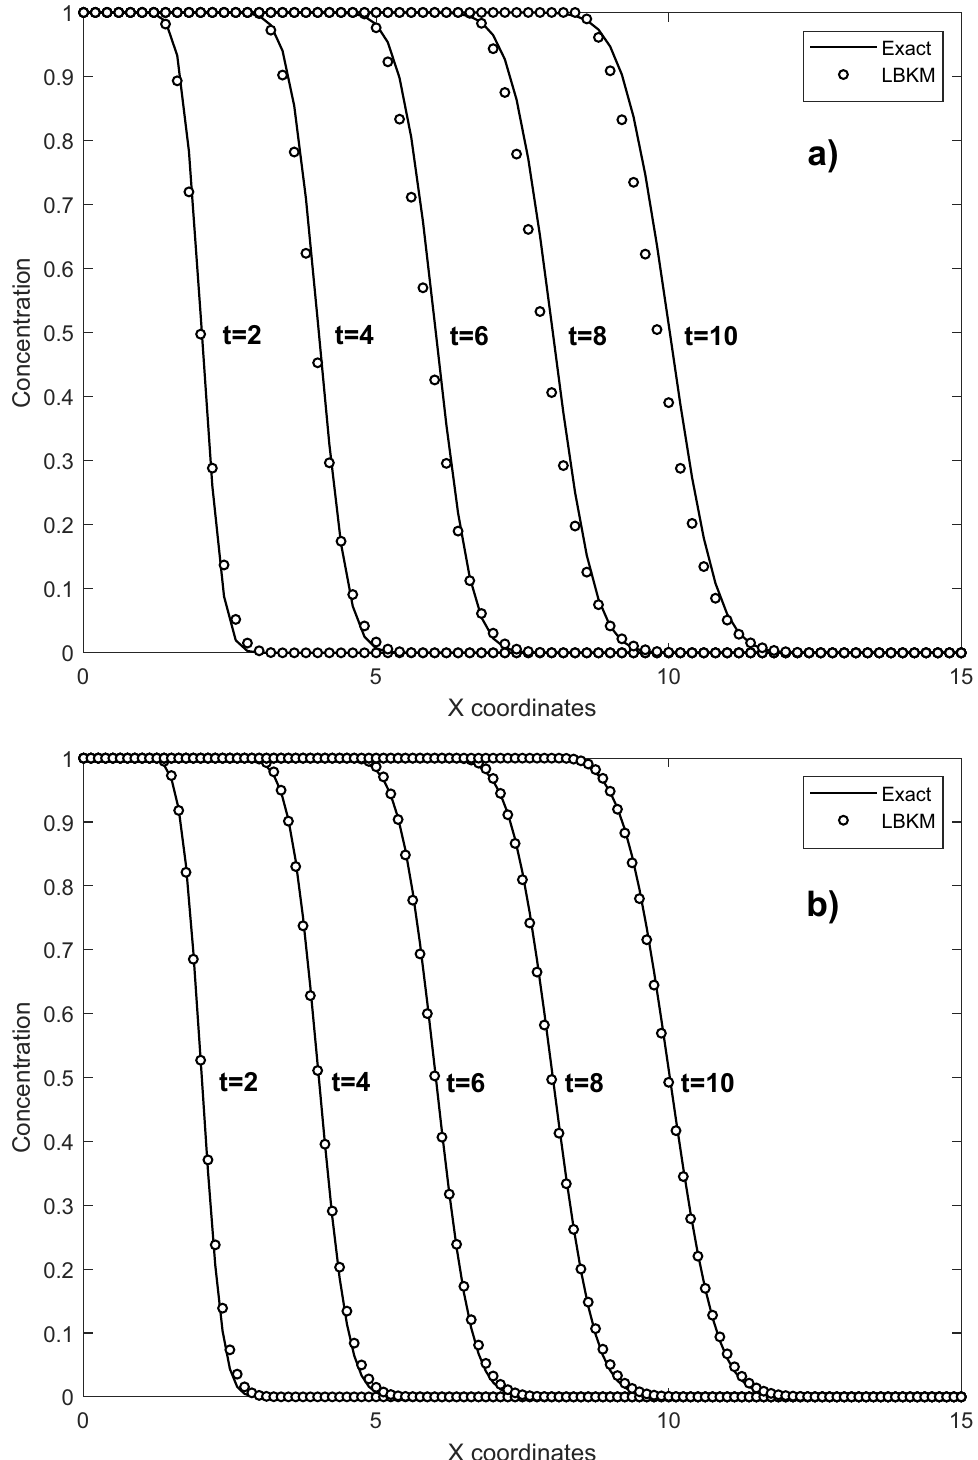
Figure 10. Example No. 3—concentration profiles for Pe = 1000: ( a ) Grid 101 × 11, ( b ) Grid 161 ×